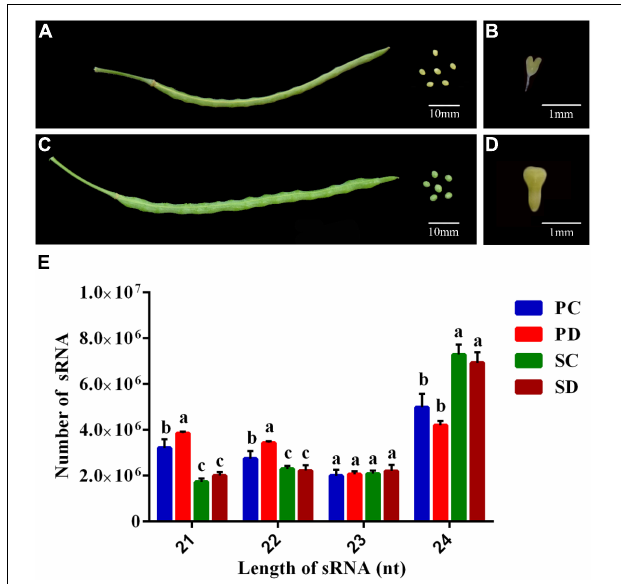
FIGURE 1 | Phenotypes of siliques, seeds, and embryos at torpedo- and early cotyledonary-embryo stages of Chinese kale and the sRNA length distribution of different libraries. (A) Phenotype of siliques and the corresponding seeds at the torpedo-embryo stage of Chinese kale. The scale bar represents 10 millimeters (mm). (B) Torpedo embryo in siliques at (A) . The scale bar represents 1 mm. (C) Phenotypes of siliques and the corresponding seeds at the cotyledonary-embryo stage of Chinese kale. The scale bar represents 10 mm. (D) Early cotyledonary-embryo in siliques at (C) . The scale bar represents 1 mm. (E) Length distribution of sRNA in PC, PD, SC, and SD. The X -axis represented the lengths of sRNA ranging from 21 to 24 nucleotides (nt). The Y -axis is the number of sRNA at a specific length. Error bars represent the SE of three biological replicates. The differences labeled with distinct letters were considered significant at p < 0.05. PC and SC mean sRNA libraries of silique walls and seeds at the torpedo-embryo stage, respectively. PD and SD mean sRNA libraries of silique walls and seeds at the cotyledonary-embryo stage, respectively.